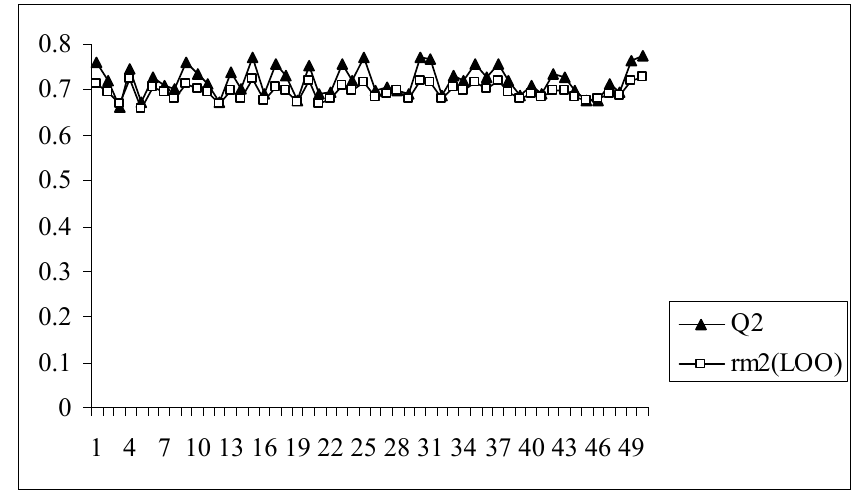
Figure 10. Comparative plots of Q 2 and r m2